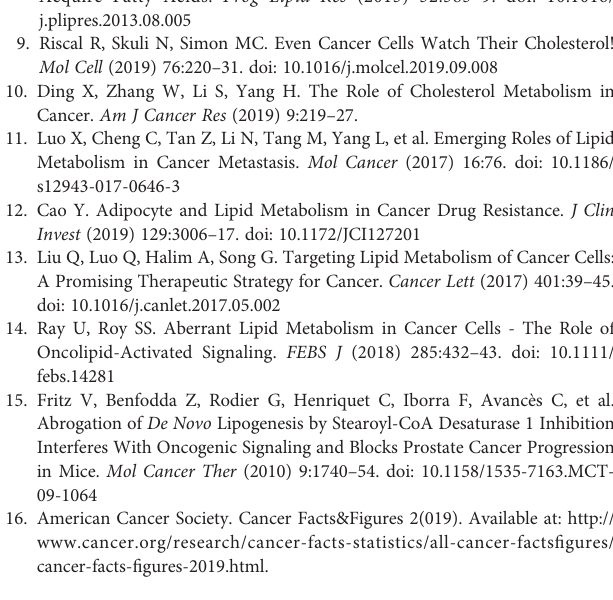
Supplementary Figure 1 | Lipid-related differentially expressed genes (DEGs) in HNSCC of GEO datasets. (A, B) showed 65 lipid DEGs in GEO database, GSE30784 andGSE37991respectively(p<0.01, |logFC|>2).Thecolor fromblueto redrepresented the gene expressions from high to low between tumors vs. normal tissues. Supplementary Figure 2 | LRPSinthe GEO dataset. (A) Survival analysisshowed a signi fi cant difference between high-risk group and low-risk group in GSE65858 dataset (p=4.304×10-5). (B) The 5-year ROC value in the GEO group is 0.811. Supplementary Figure 3 | LRPS in the TCGA validation dataset. (A, B) Three mRNA expression and risk score division in the TCGA validation dataset. (C) . Survival analysisshowedasigni fi cantdifferencebetweenhigh-riskgroupandlow-riskgroupin TCGA validation dataset (p=1.337×10-5). (D) . The 3-year, 5-year and 10-year ROC values in the validation group are 0.625, 0.618 and 0.592, respectively. Supplementary Figure 4 | The relationship between LRPS and tumor mutational burden. Correlation analysis between LRPS score and total tumor mutational burden (TMB) in HNSCC from TCGA